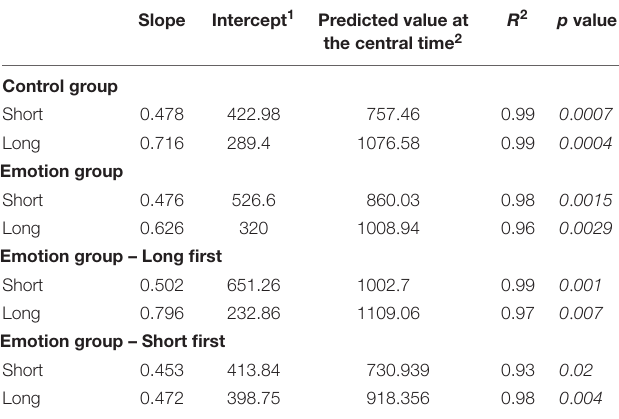
TABLE 1 | Slope and intercept obtained from the linear regression performed on the averaged data in each condition. Slope Intercept 1 Predicted value at R 2 p the central time 2